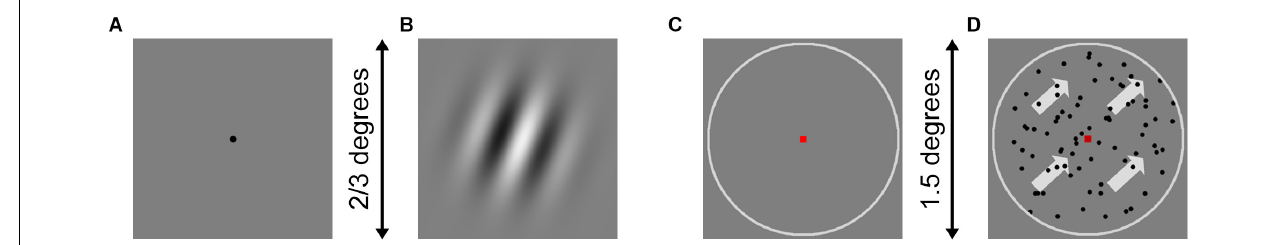
FIGURE 1 | Example stimuli for orientation and motion direction tasks. (A) The fixation dot for orientation was presented at first while waiting for the participants to prepare. (B) When participants pressed the space button, the fixation dot disappeared, and the Gabor patches were presented for 150 ms. The spatial frequency of the Gabor patch was 3 cyc/deg and filtered with a gradual Gaussian blur from the center to the edge and a circle mask. The visual angle of the Gabor patch was 2/3 ◦ when participants sit 1,500 mm in front of the screen. (C) The fixation square and circle for motion direction were presented at first while waiting for the participants to prepare. (D) When the participants pressed the space button, the moving dots moved in the same direction for 200 ms. The visual angle of the white circle was 1.5 ◦ for the participants when 1,500 mm in front of the screen.